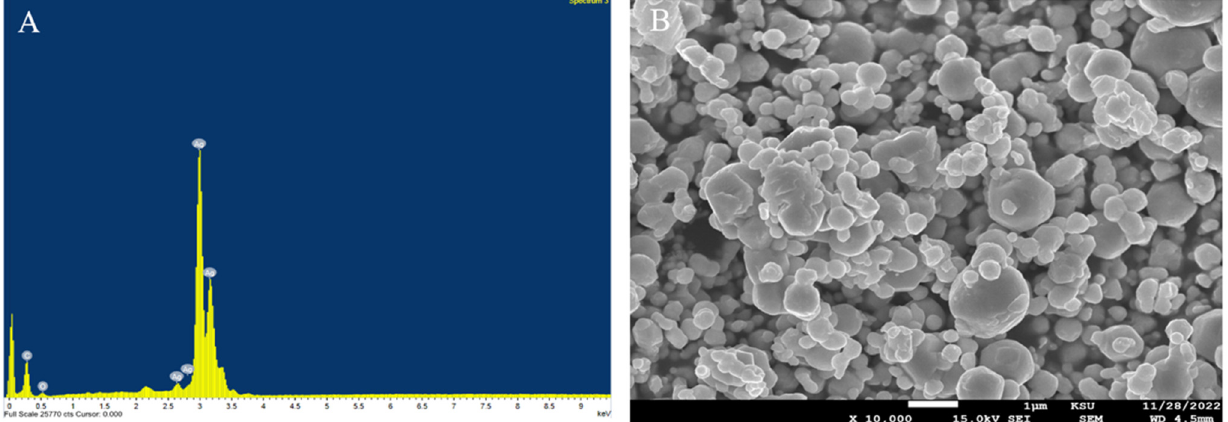
Figure 2. ( A ) EDS compositional analysis of elements, ( B ) SEM image showing the distribution of spherical and semi-identical particles of AgNPs.